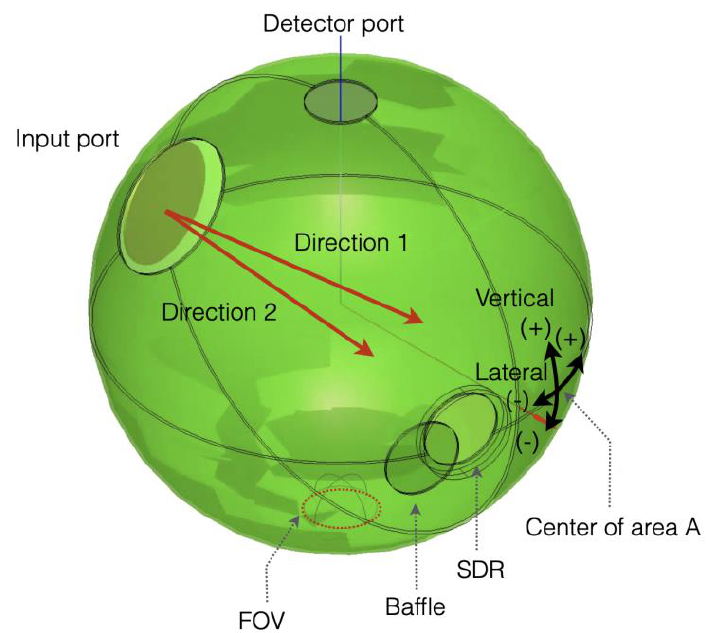
Figure 6. Absolute reflectometer virtually built in 3D space for ray-tracing simulation. The vertical and lateral black arrows at the center of area A show the direction of misalignment in the simula-